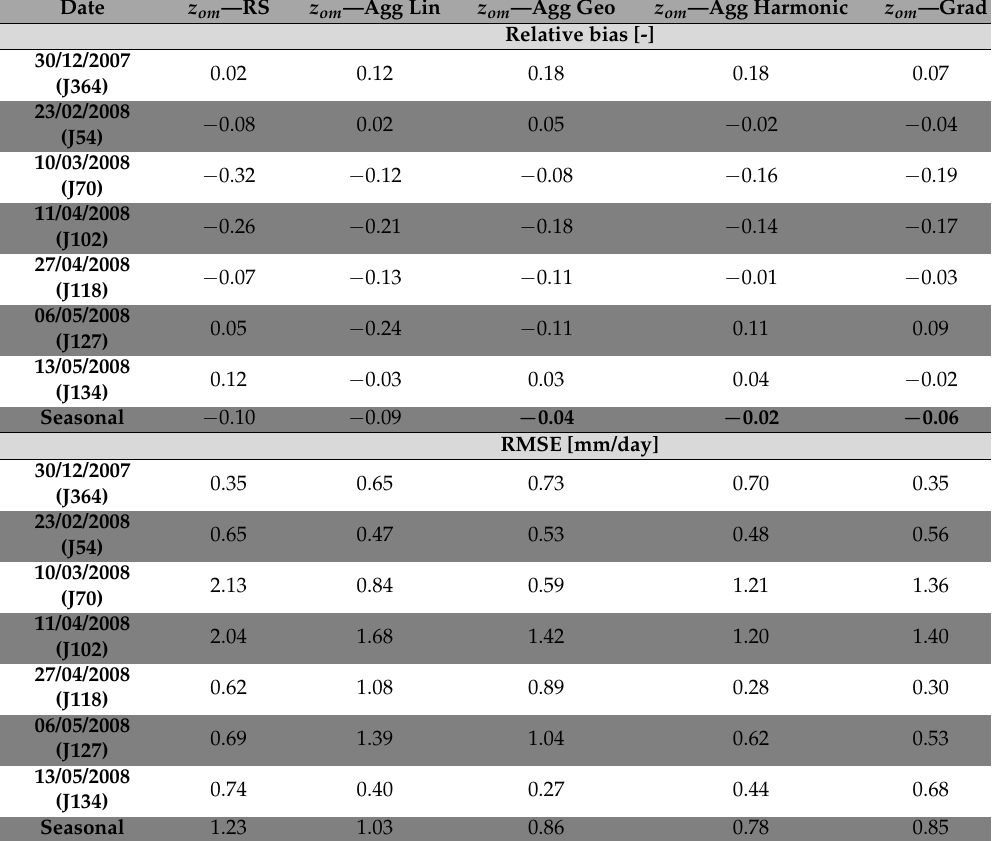
Table 3. Relative biases for the ‘agg ASTER’ vs. MODIS produced with SEBS at low resolution for different methods to estimate the LR surface roughness length parameter (the same symbols as Table